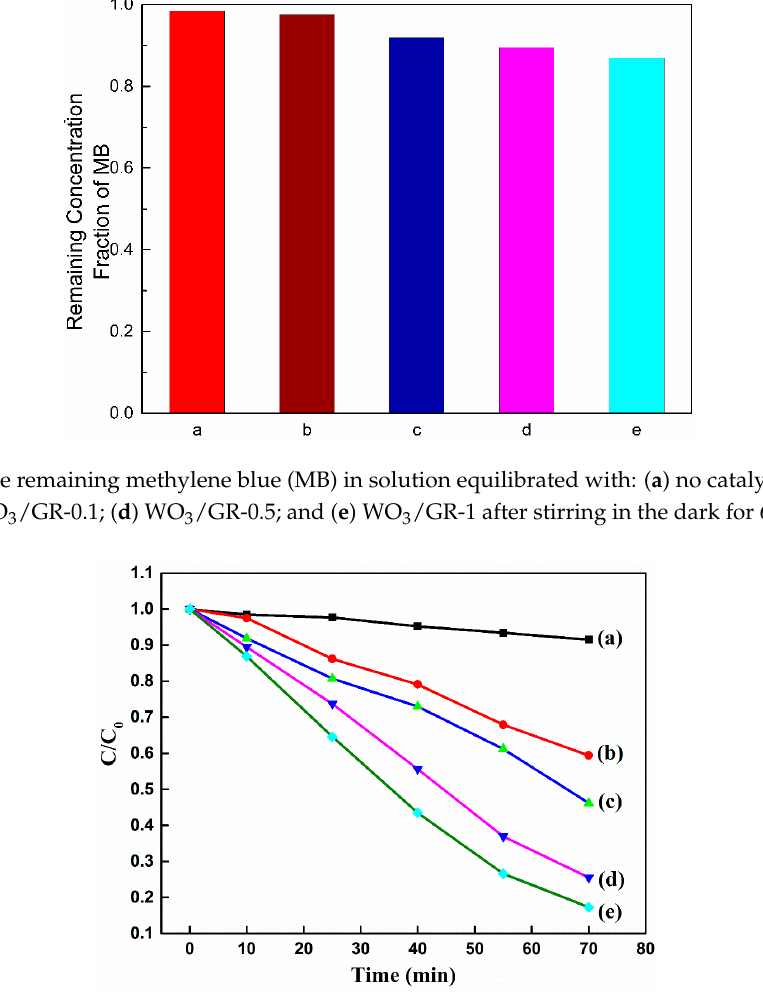
Figure 10. Photodegradation of MB under visible light: ( a ) no catalyst; ( b ) pure WO 3 ; ( c ) WO 3 /GR-0.1; ( d ) WO 3 /GR-0.5; and ( e ) WO 3 /GR-1.